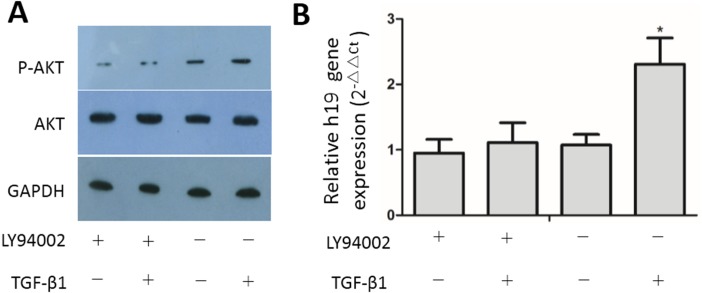
Inhibition of the PI3K/AKT pathway suppressed activation of TGF-β1-induced upregulation of H19 expression.Confluent MAC-T cells were serum-starved for 24 h and pretreated with the inhibitor at 20 µM in serum-free media for 30 min, and then the cells were treated with TGF-β1 at 2 ng/mL for 36 h. (A) Phosphorylated Akt and total Akt expression in cells was analyzed by western blotting. (B) Expression of H19 in cells was analyzed by RT-qPCR. GAPDH was used as an internal control. ∗p < 0.05 vs control.